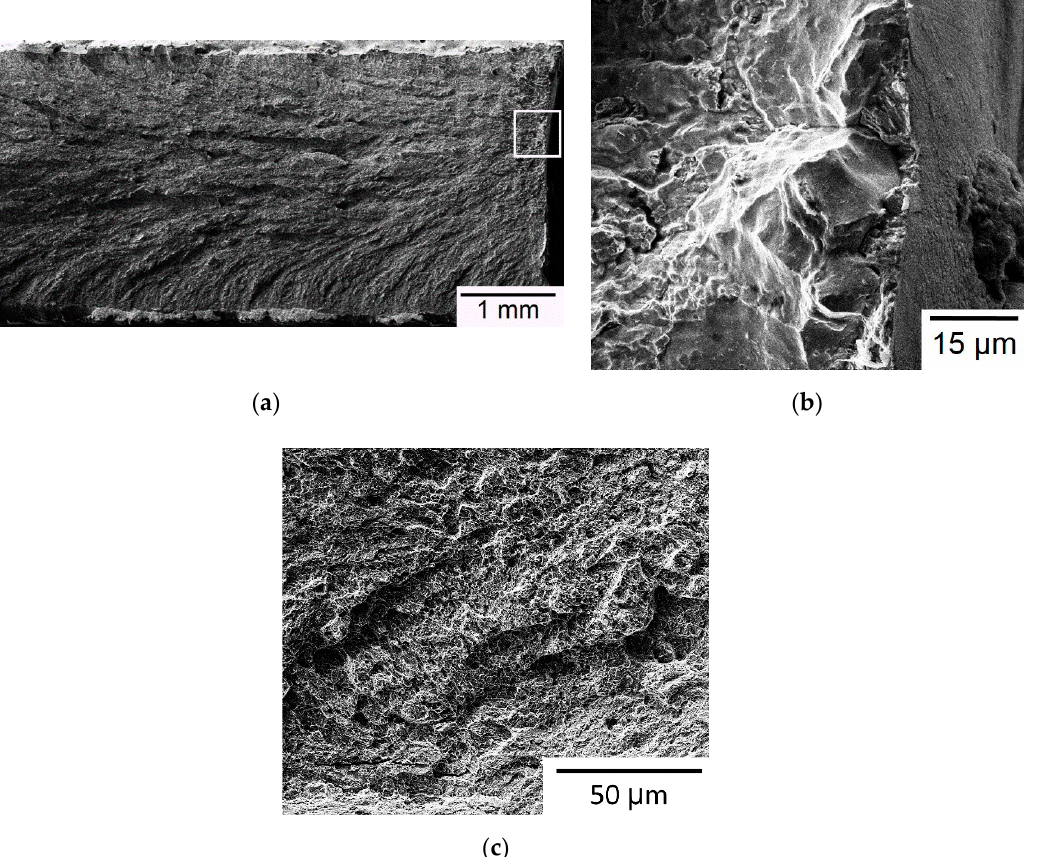
Figure 7. SEM micrographs of a Group B specimen: ( a ) Overview of fracture surface; ( b ) high-magnification view of the outlined fracture origin zone in ( a ); ( c ) high-magnification view of a region away from the fracture origin.